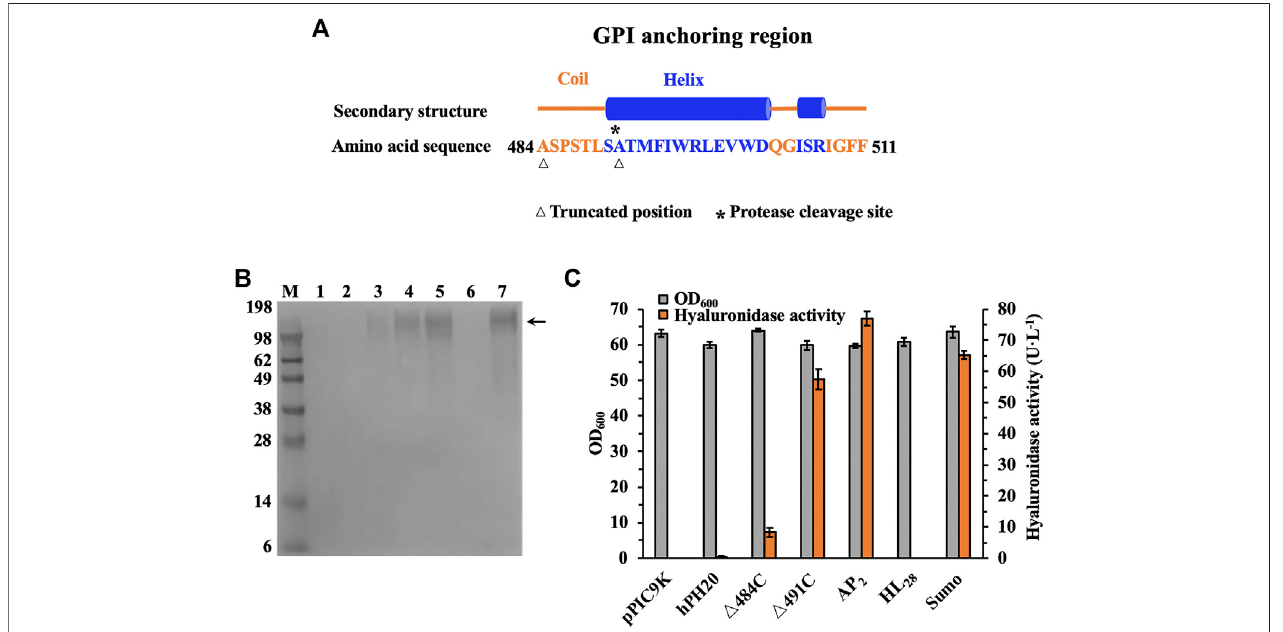
FIGURE 2 | Expression and activity of recombinant hPH20, truncated mutants ( △ 484C △ 491C), and △ 491C with different tags in the culture broth. (A) Secondary structure and sequence analysis ofthe GPI anchoring region. (B) Western blot analysis of the recombinant hPH20, truncated mutants ( △ 484C △ 491C), and △ 491C with differenttags.M:standardproteinmarker;1:control;2:recombinanthPH20;3: △ 484C;4: △ 491C;5:AP 2 ;6:HL 28 ;7:Sumo.Thetruncatedmutants( △ 484C △ 491C)and △ 491C with different tags are shown by the black arrow. (C) Hyaluronidase activity of recombinant hPH20, truncated mutants ( △ 484C △ 491C), and △ 491C with different